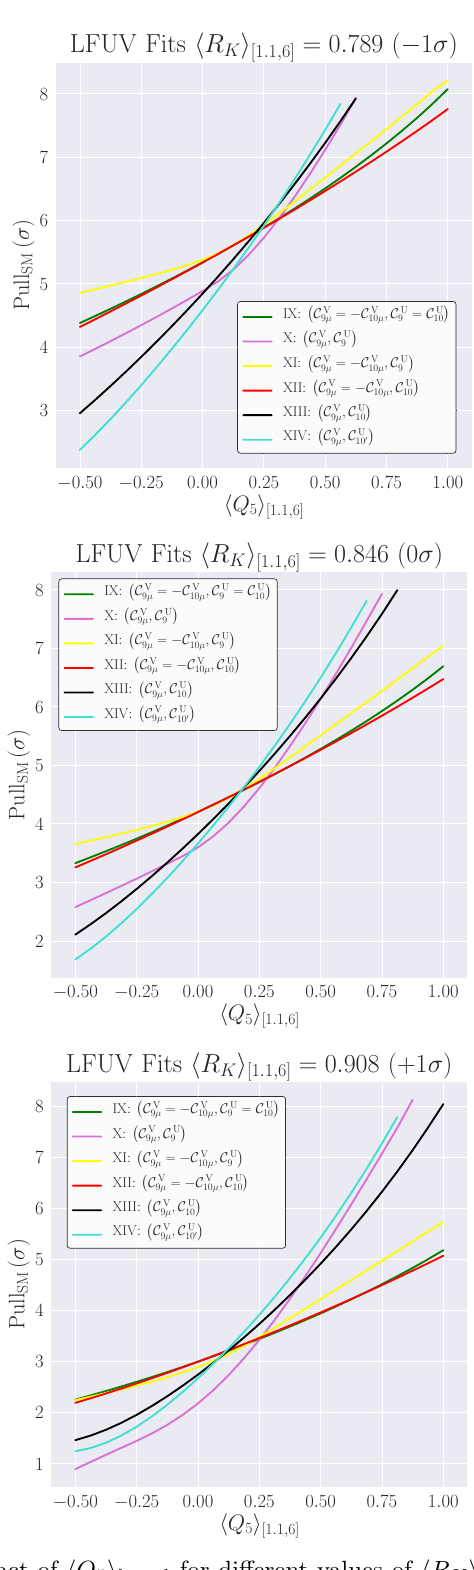
Figure 9. LFUV fit: impact of NP hypotheses under